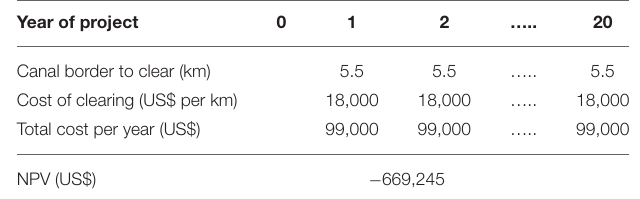
TABLE 9 | Cost of removal of invasive aquatic vegetation in the